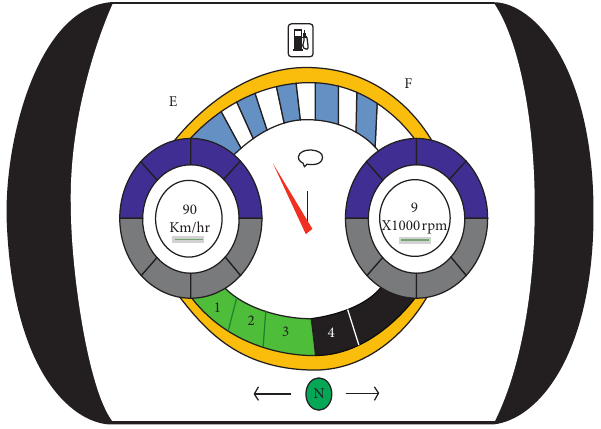
Figure 3: Automobile dashboard.